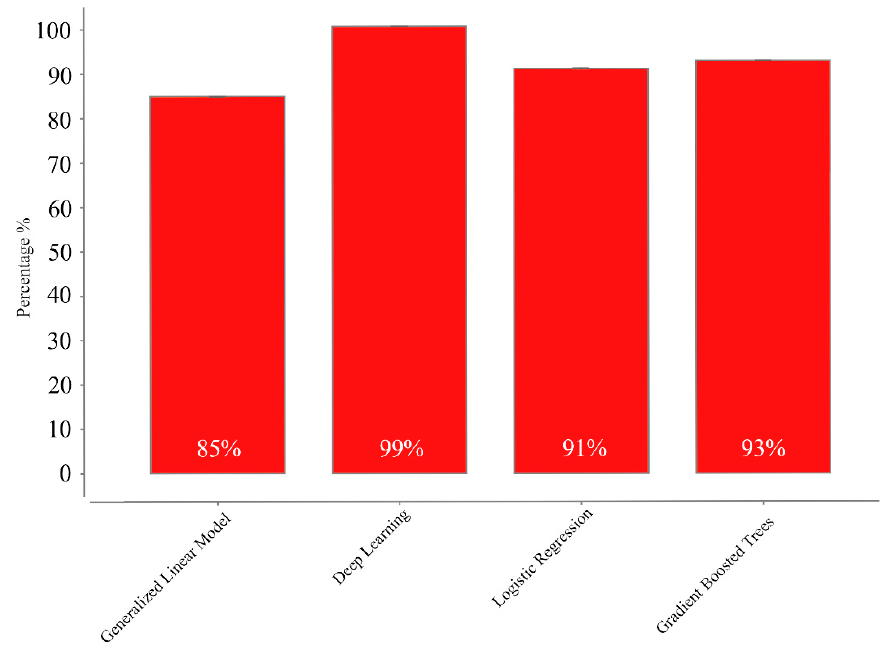
Figure 5. Accuracy of the candidate models.